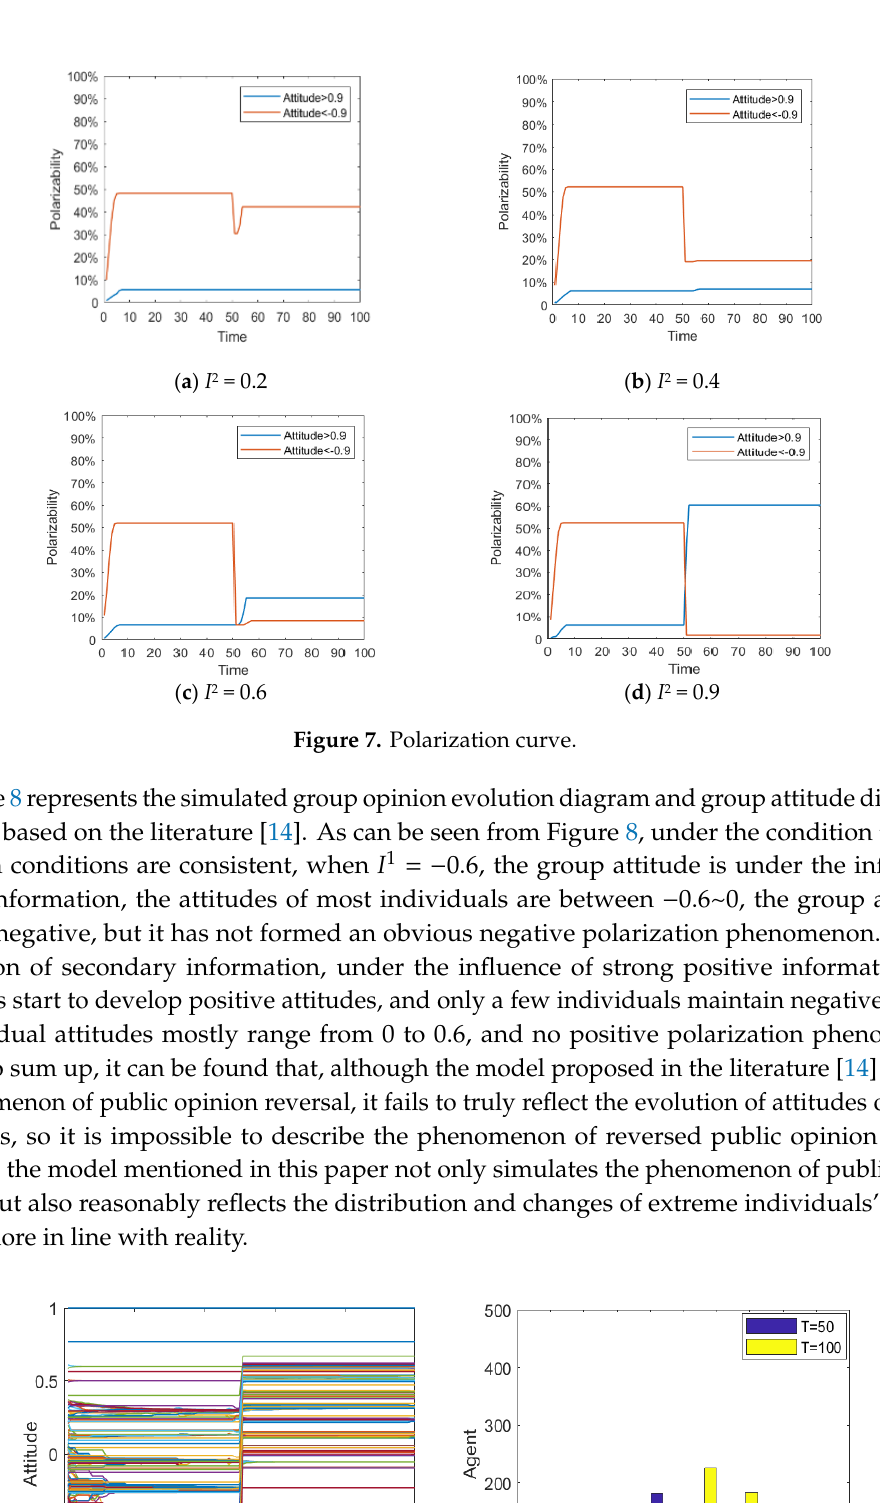
Figure 6. Group attitude distribution histogram. ( a ) I 2 = 0.2; ( b ) I 2 = 0.4; ( c ) I 2 = 0.6; ( d ) I 2 = 0.9.